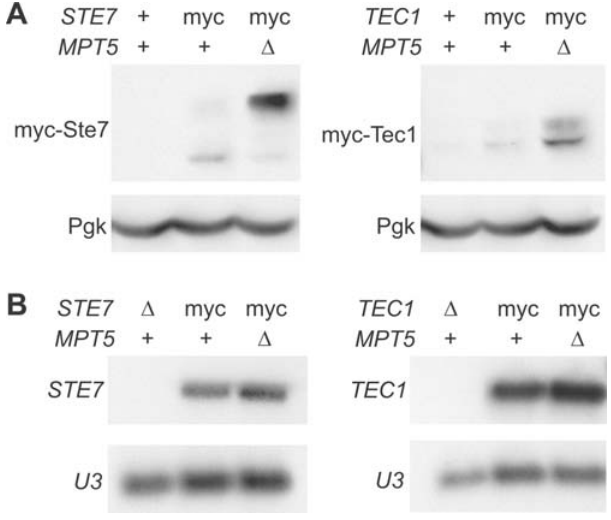
Figure 3. Repression of Ste7 and Tec1 protein levels by MPT5 . (A) Yeast strains were grown under yeast-form conditions. Protein extracts were analyzed by western blot, with Pgk serving as a loading control. (B) RNA extracts were analyzed by northern blot, with U3 serving as